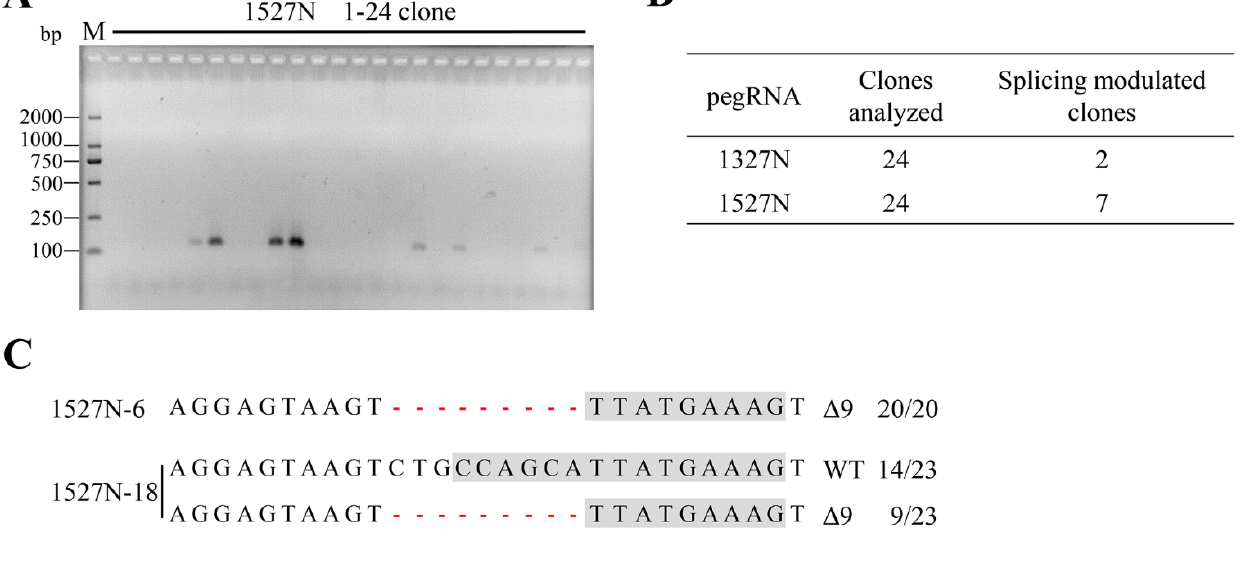
Figure 2. Targeted-deletion and screening. ( A ) Twenty-four candidate mono-clones of 1527N were picked, followed by genomic DNA extraction and PCR analysis using a specific primer. The targeted-deletion obtained a 121 bp band. M, DL2000 DNA ladder. ( B ) Splicing-modulation efficiencies by targeting ISS-N1. ( C ) T-A cloning and sequencing of the positive clones. The deletions are indicated by a red dashed line. The column on the right indicates the percent of the relevant genotype in total sequencing reads. For 1527N-6, all the 20 reads were 9-nt deleted, which indicated 1527N-6 has three targeted-deletion copies. 1527N-18 has 14 reads with WT genotype and 9 reads with deleted 9-nt, indicating one targeted-deletion copy with two unedited copies. WT, wild-type. Δ , deletion.